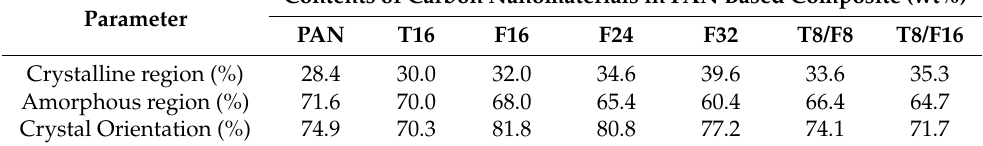
Table 7. Degree of the crystal orientation in the PAN-based composite yarn with different contents of carbon